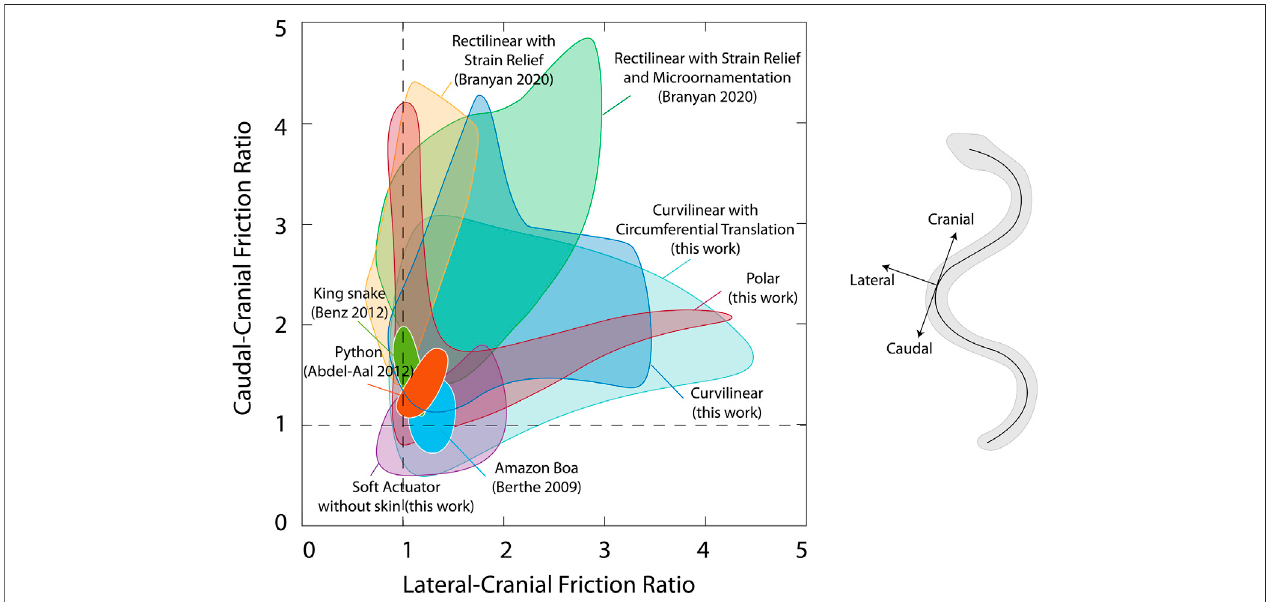
FIGURE 6 | Ashby diagram representing caudal-cranial friction ratio versus lateral-cranial friction ratio for the proposed kirigami skins compared to previous iterationofskin designusingmicroornamentation (Branyanetal.,2020)and biologicalfrictiondatareportedintheliterature (Bertheetal.,2009;Benzet al.,2012;Abdel- Aal,